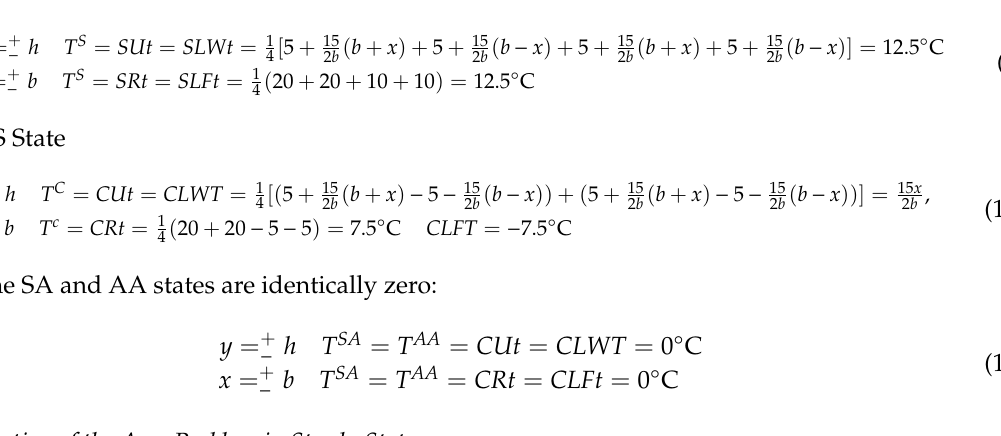
Figure 5. Antisymmetric part relative to x and symmetric to y . AS state.